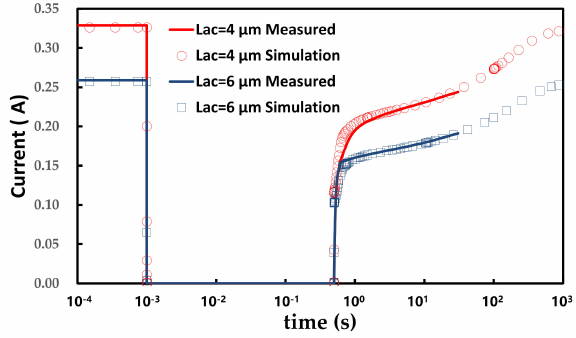
Figure 5. Dynamic measurement and simulations.